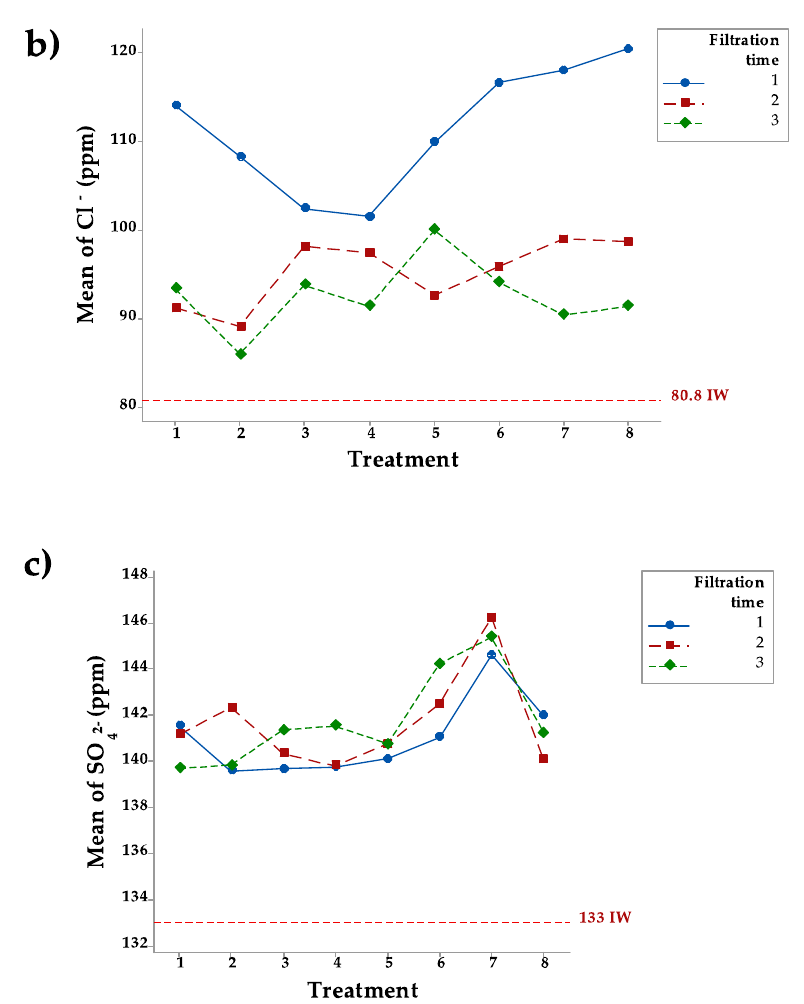
Figure 3. Concentrations of F − ( a ), Cl − ( b ), and SO 42 − ( c ) after three filtrations in eight treatments.